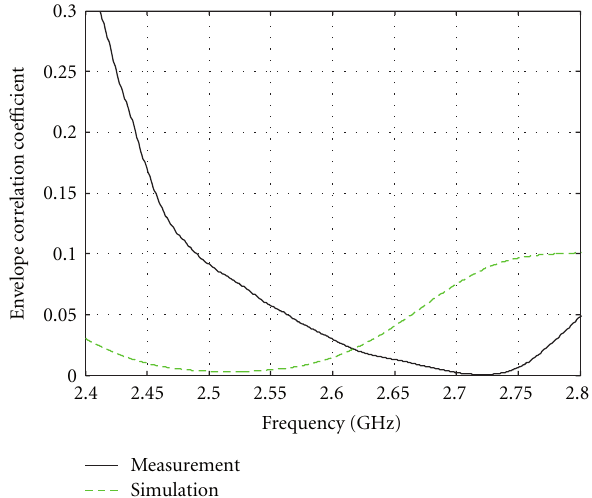
Figure 17: Envelope correlation coe ffi cient of the MIMO antenna system #3 (measurements versus